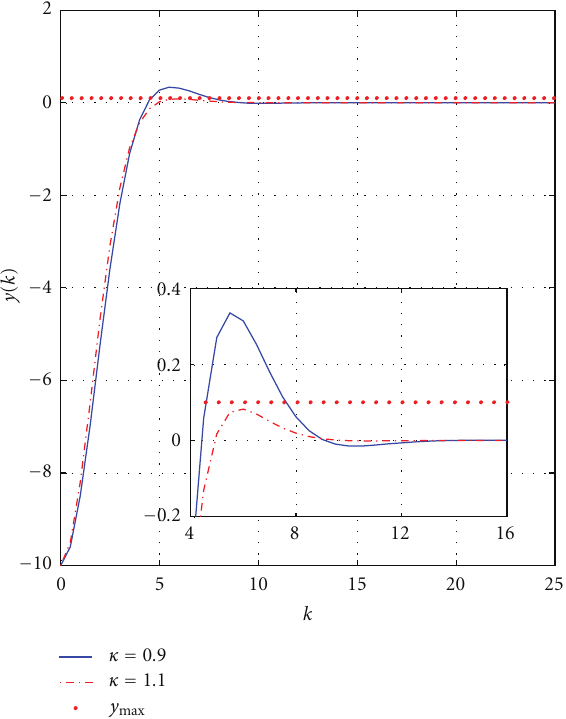
Figure 4: Simulation results using relaxed output